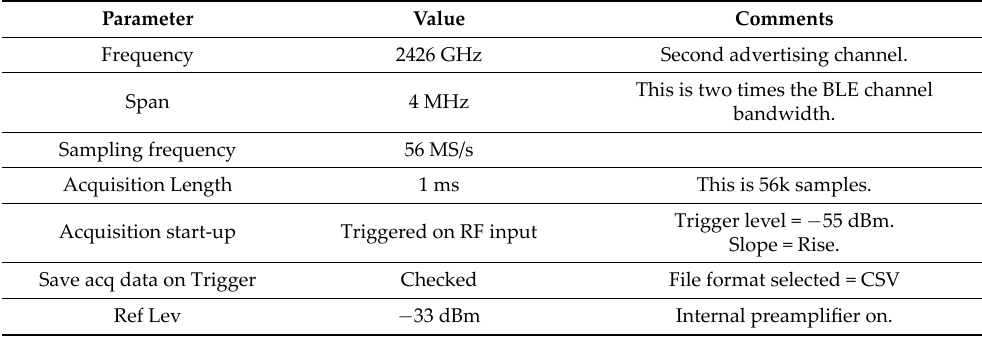
Table 2. Configuration parameters of the RSA306B real‑time spectrum analyzer.